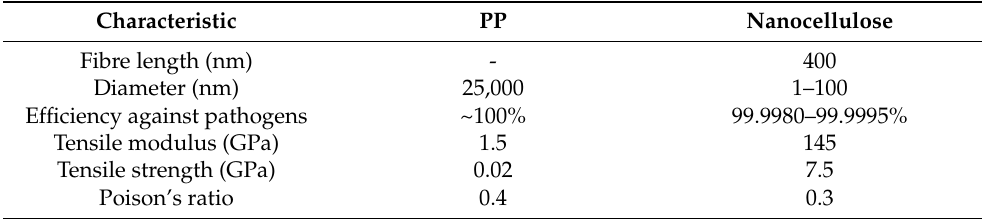
Table 3. Comparison of PP and nanocellulose